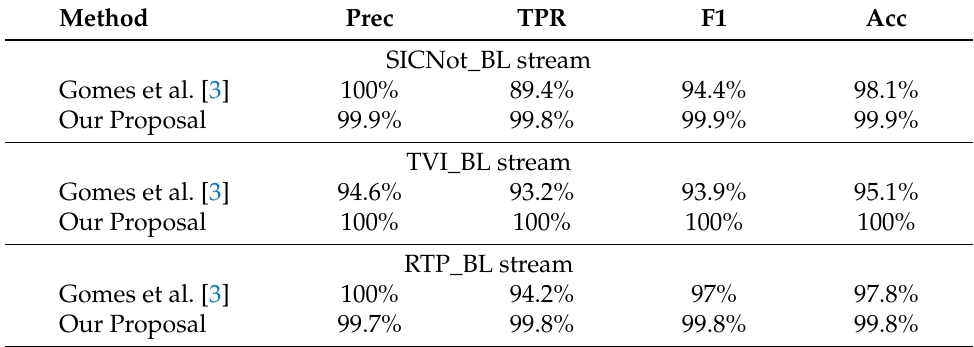
Table 7. Comparison of the results obtained using the proposed method and the advertisement detection method proposed in